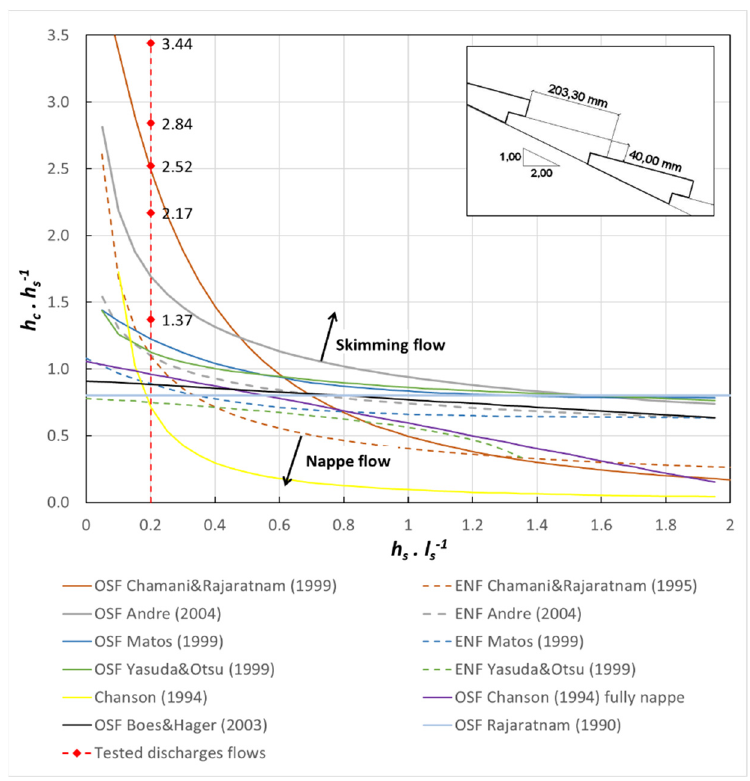
Figure 6. Flow regime (skimming, transition and nappe flow) for the tested discharges according to the criteria of [40–45].